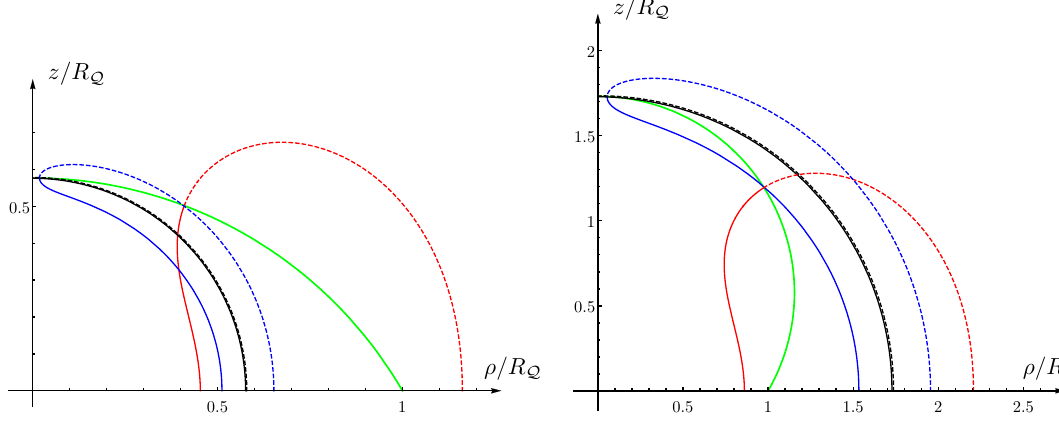
Figure 16 . Radial pro(cid:12)les of extremal surfaces ^ (cid:13) con intersecting Q (green curve) orthogonally A and anchored to a disk A of radius R (cid:14) concentric to a circular boundary with radius R Q (see section 4.1.1). Here (cid:11) = 2 (cid:25)= 3 (left panel) and (cid:11) = (cid:25)= 3 (right panel). Any solid line provides ^ (cid:13) con and the dashed line with the same colour gives the radial pro(cid:12)le of the corresponding auxiliary A surface ^ (cid:13) con . Here the values of k associated to ^ (cid:13) con (see (cid:12)gure 5) are k = 1 (red), k = 1000 (blue) A; aux A and k = 10 7 (black). For large k , both ^ (cid:13) con